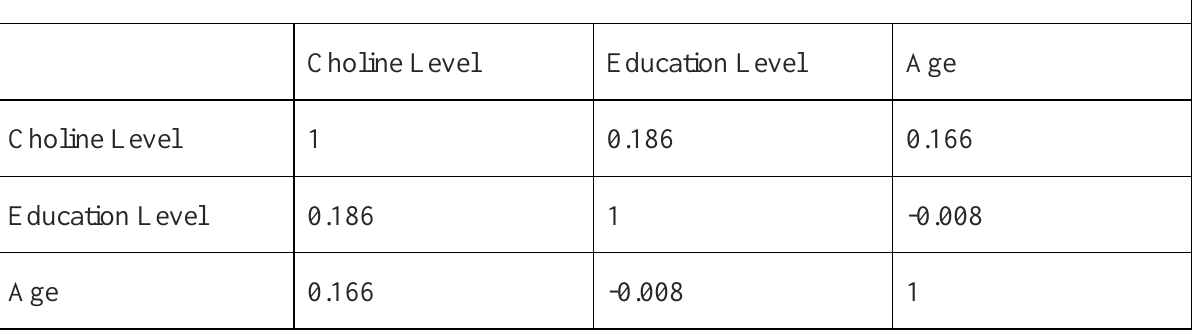
Table 4: Correlation